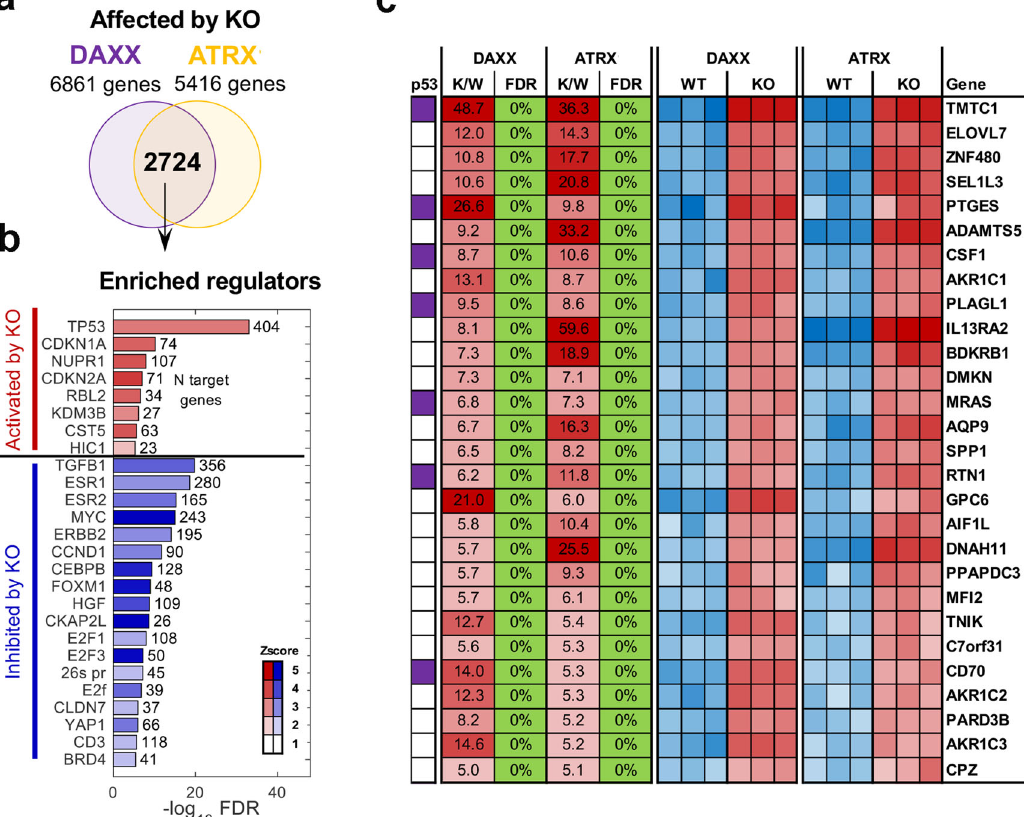
inhibited (blue) by DAXX_KO and ATRX_KO. c Expression heatmap showing top differentially regulated genes (FDR<5%, at least fi vefold) for DAXX_KO and ATRX_KO relative to WT control. Ratio of KO to WT (K/W) and false discovery rate (FDR) are shown. Known direct p53 targets are indicated